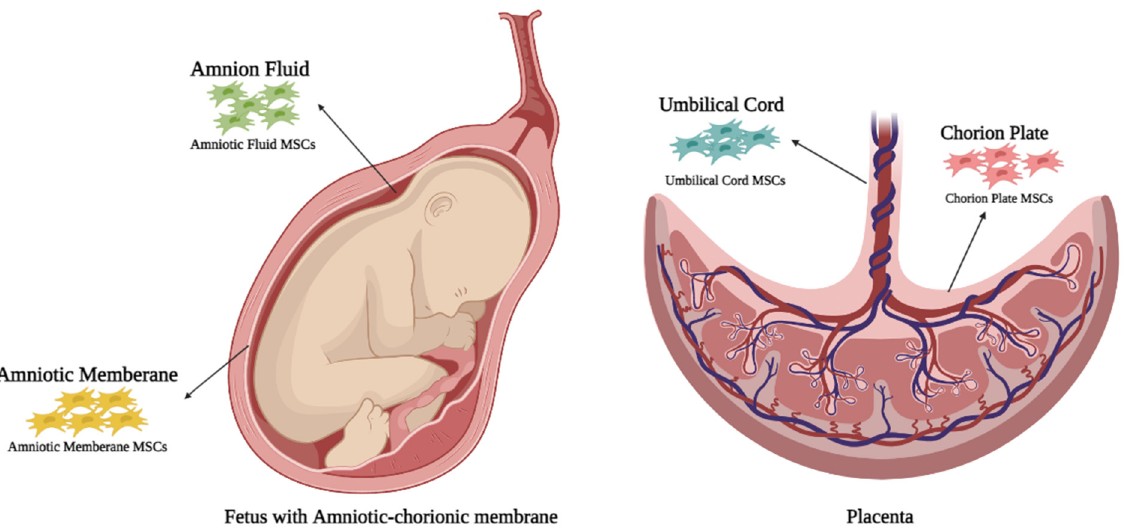
Figure 1. The extraembryonic tissues used for MSCs isolation. Amniotic membrane and amniotic fluid, located in the inner parts of the amniotic-chorionic membrane, are promising sources of MSCs. The placenta and the umbilical cord are the other potential sources of extraembryonic MSCs.